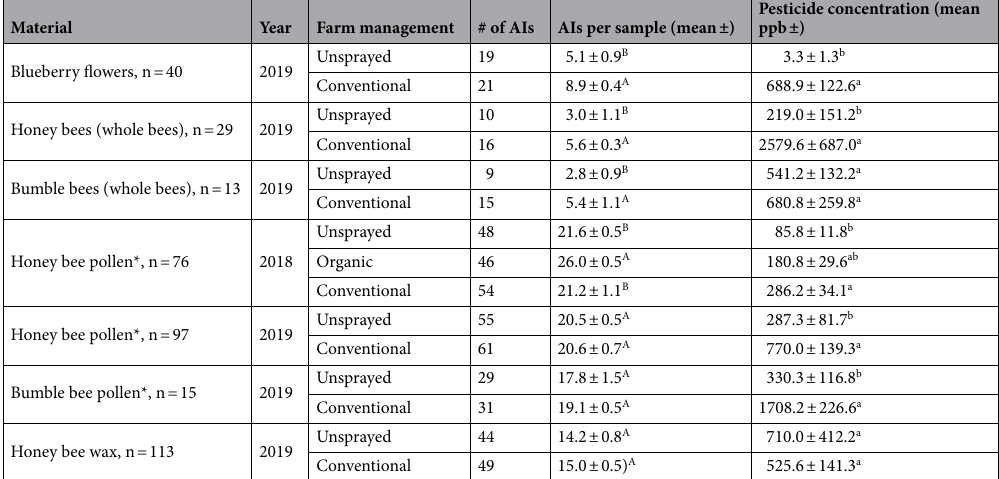
Blueberry flower samples and whole bees from conventional farms had significantly more active ingredients (Flowers: 8.9 ± 0.4 S.E.; Whole honey bees: 5.6 ± 0.3; Whole bumble bees: 5.4 ± 1.1) compared to those collected from unsprayed farms (Flowers: 5.1 ± 0.9; Whole honey bees: 3.0 ± 1.1; Whole bumble bees: 2.8 ± 0.9) ( p < 0.05, Table S5; Table 1). There was no significiant difference in average number of AIs in pollen from conventional